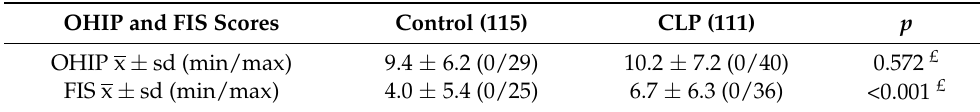
Table 3. Demographic statistics for the sample studied.